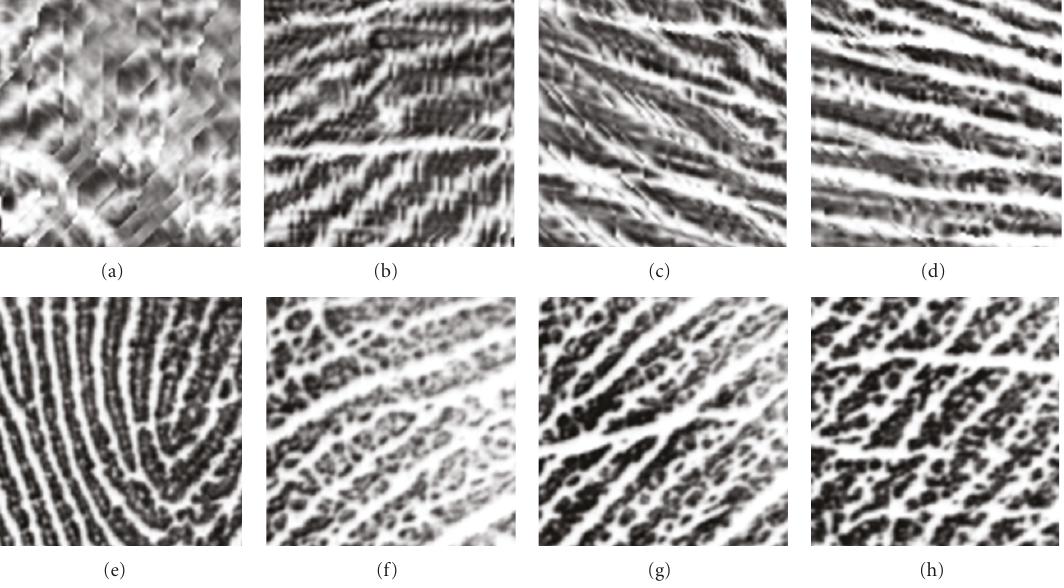
Figure 6: Smear images versus normal images. (a)–(d) smear images with high-frequency texture patterns and (e)–(h) normal images of poor